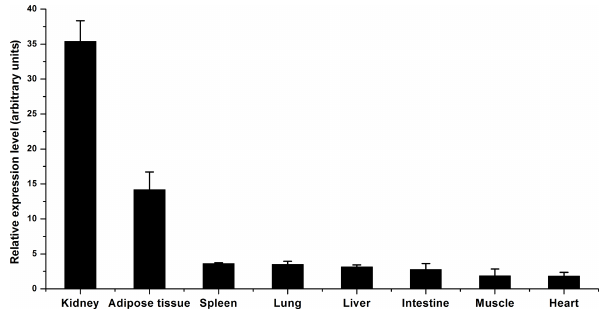
Figure 1. Tissue distribution of bovine PPARD mRNA assessed by RT-PCR. Values shown in this figure are averages of three indepen- dent experiments. Error bars represent SD ( n = 3) of relative mRNA levels. Expression data were normalized using geometric mean of mRNA levels for two control genes ( TUBA1A and β -actin).